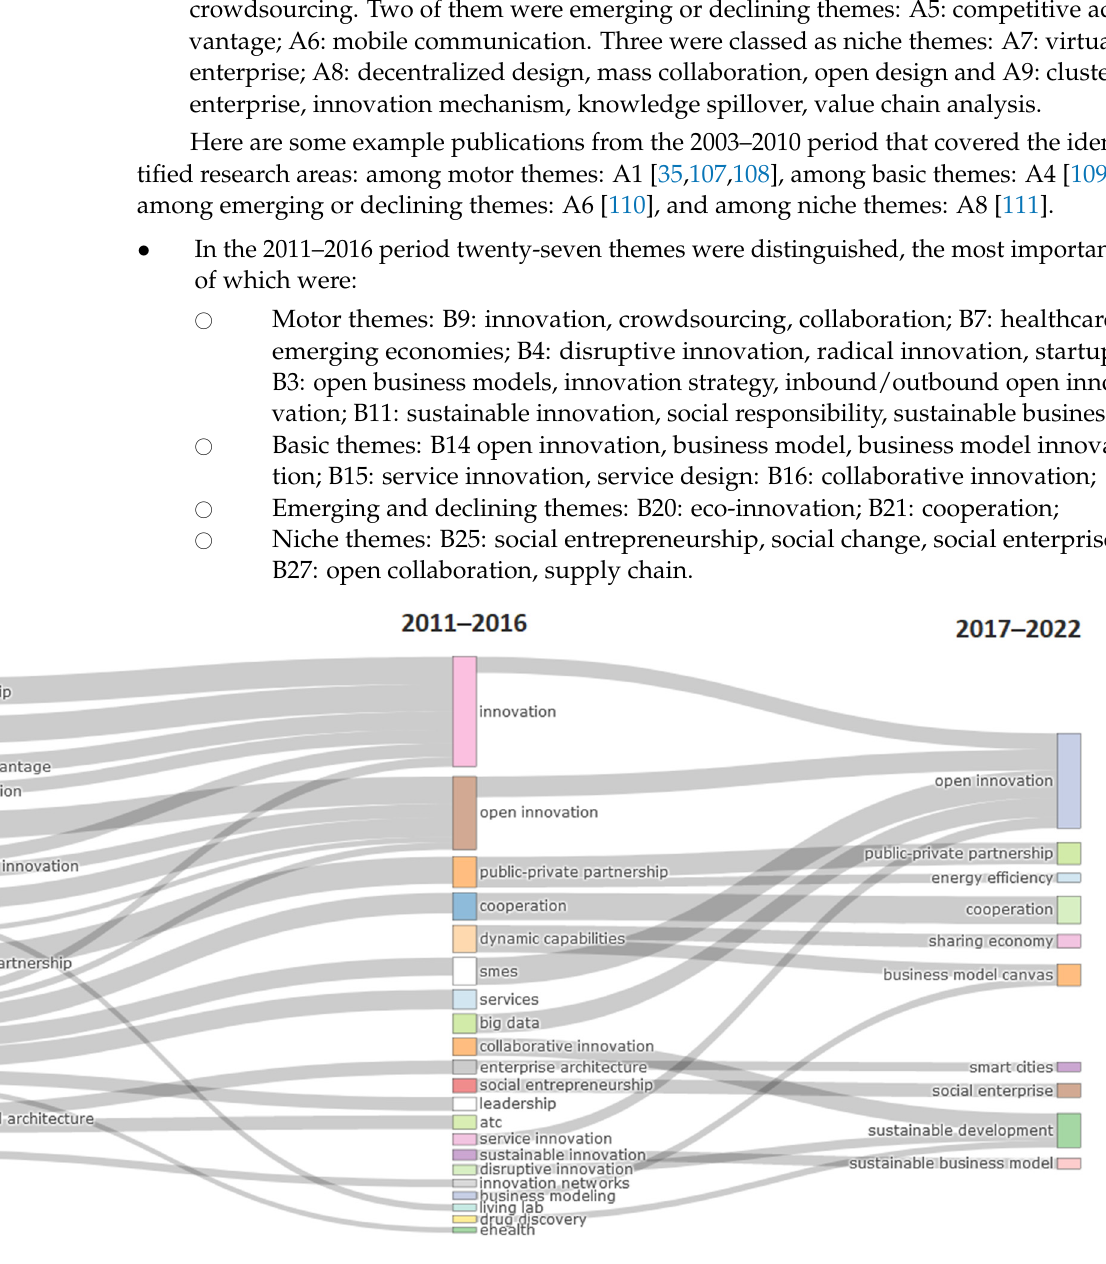
Figure 5. Thematic evolution of the BM&OI literature.